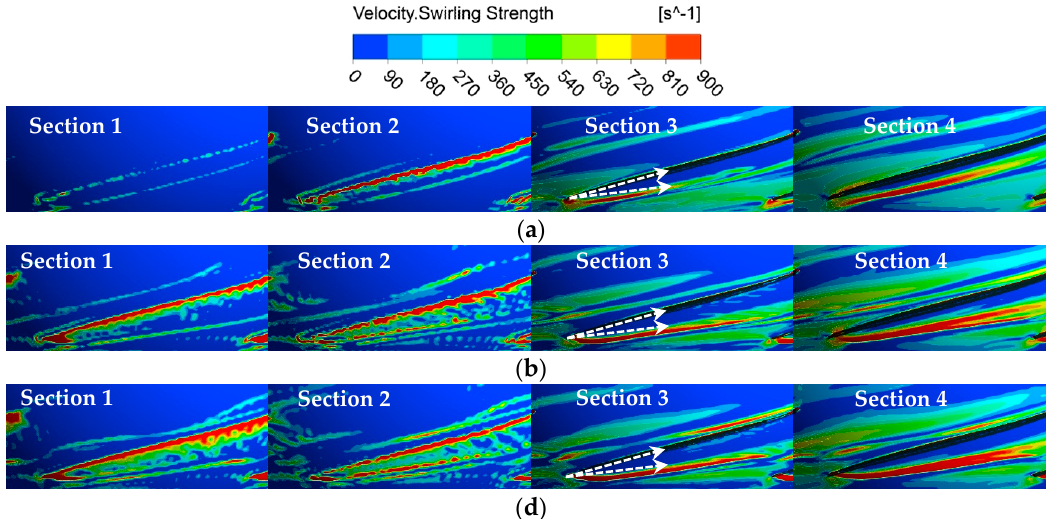
Figure 11. Velocity swirling strength distribution on different circumferential sections. ( a ) δ = 0.2 mm; ( b ) δ = 0.65 mm; ( c ) δ = 1.0